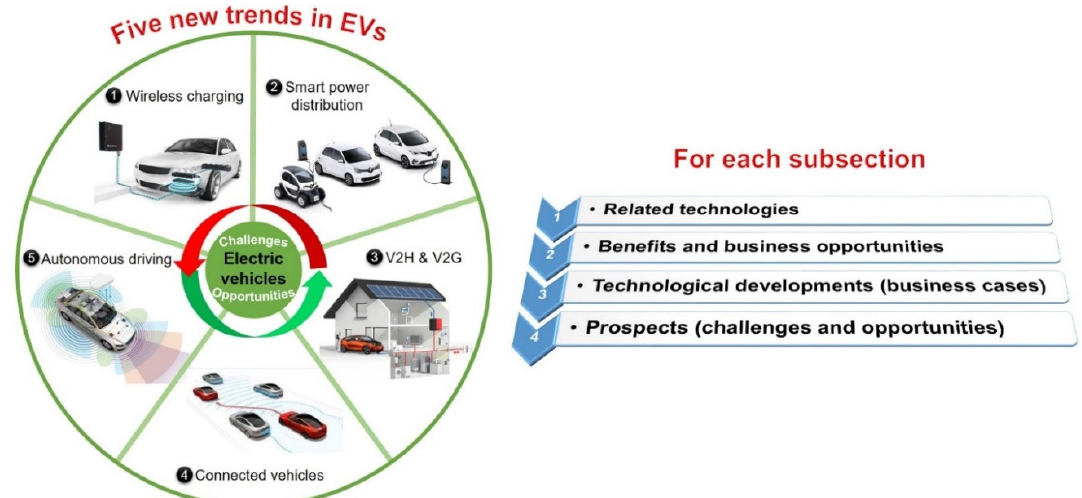
Figure 1. Structure and highlights of this review.